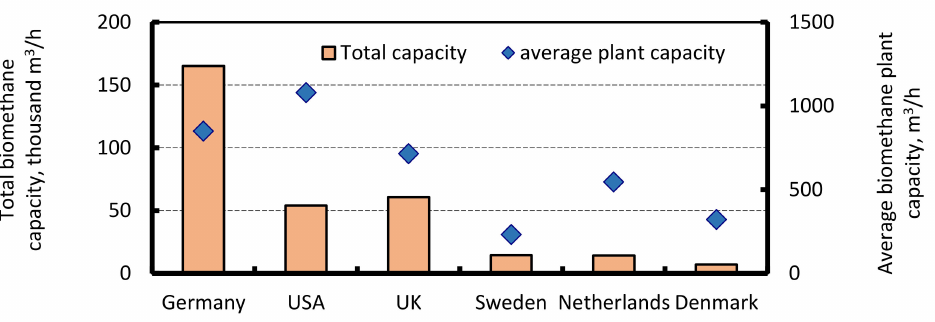
Figure 10. Capacity of biomethane